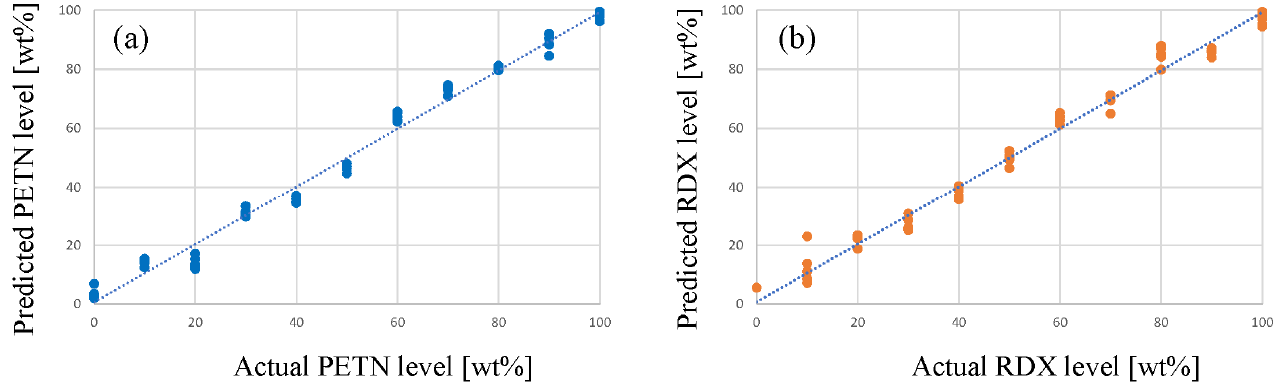
Figure 8. PLS model (seven principal components) performance for binary mixtures of PETN ( a ) and RDX ( b ). The regression line is created from the full mixture data set (n = 55, 5 spectra per composition, 11 compositions), whereas the individual markers show the random cross-validation (20 segments of 2–3 random samples) results for samples not included in the calibration.